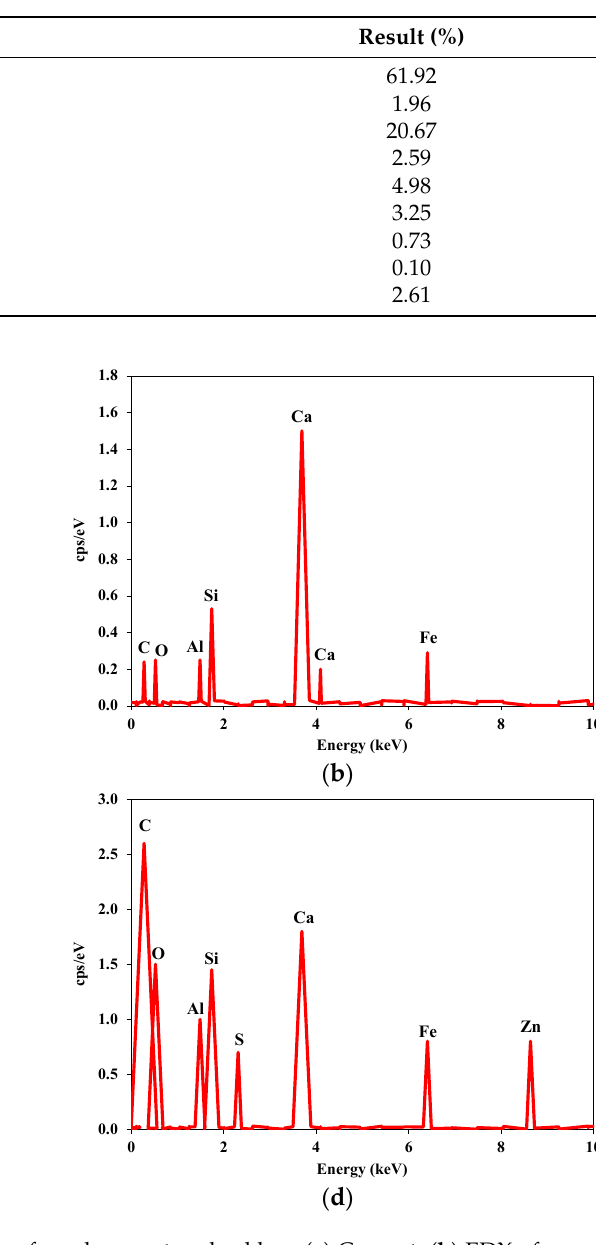
Table 4. Chemical properties of used cement.